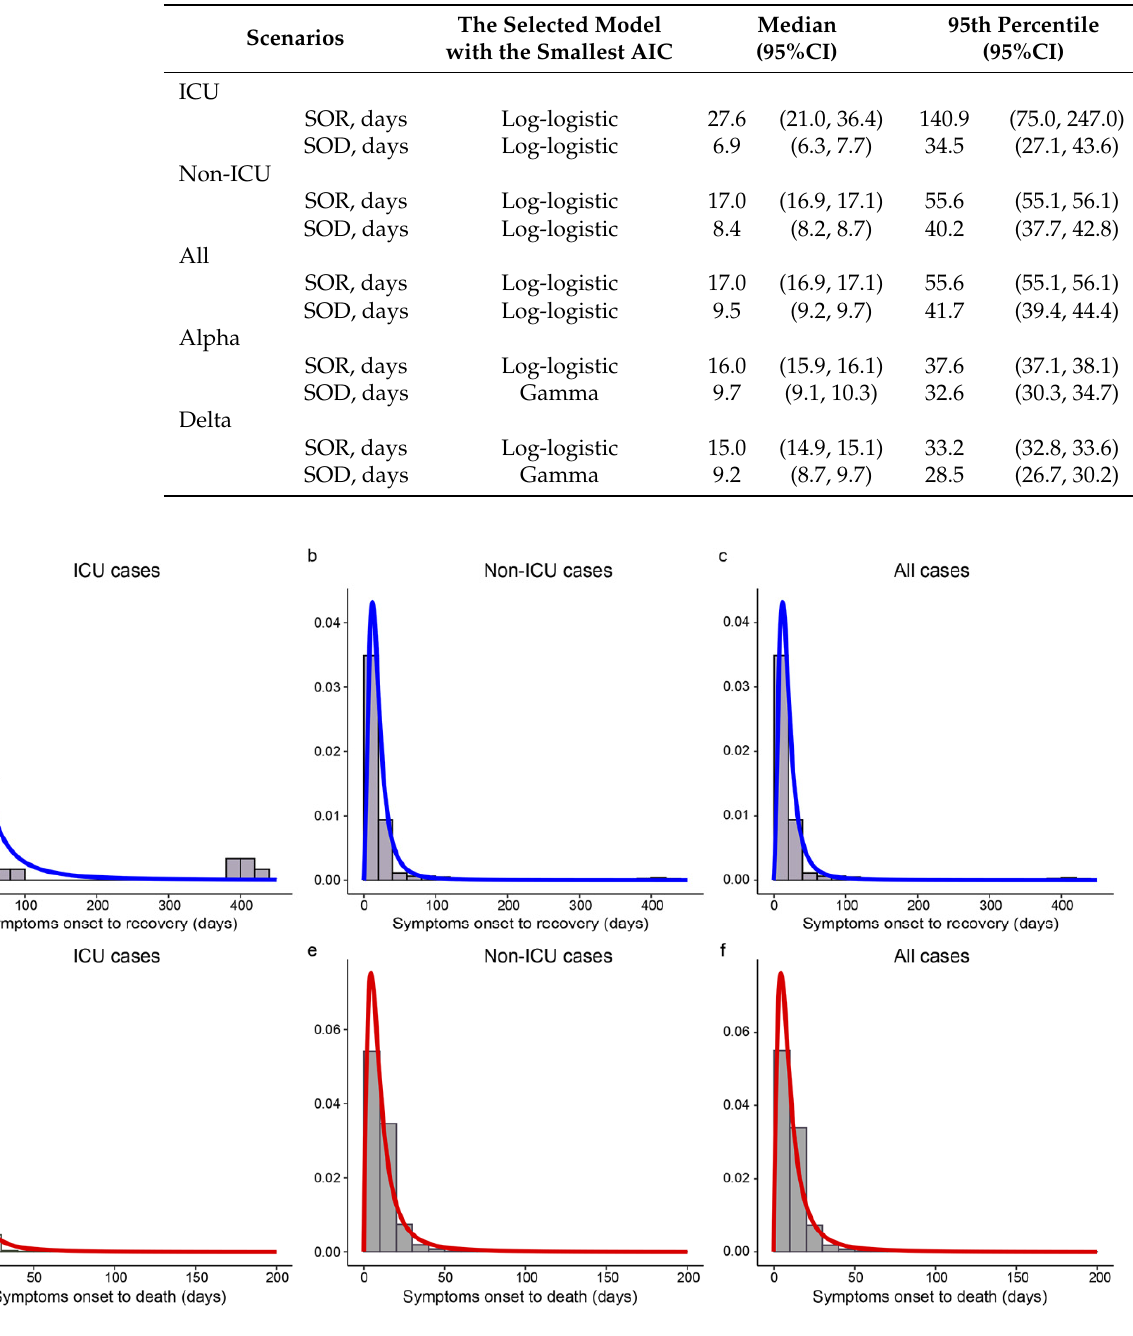
Table 2. The estimated medians of SOR and SOD based on the selected models.